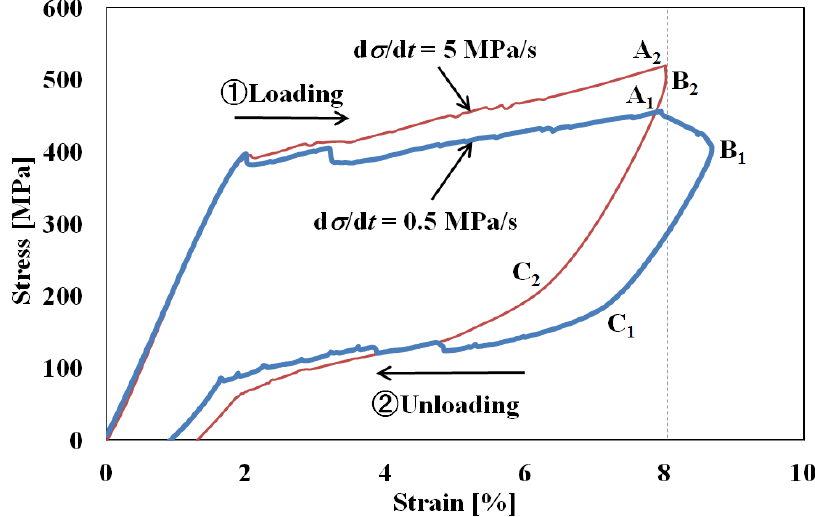
Figure 3. Stress-strain curves under stress rates of d σ /d t = 0.5 MPa/s and d σ /d t = 5 MPa/s.